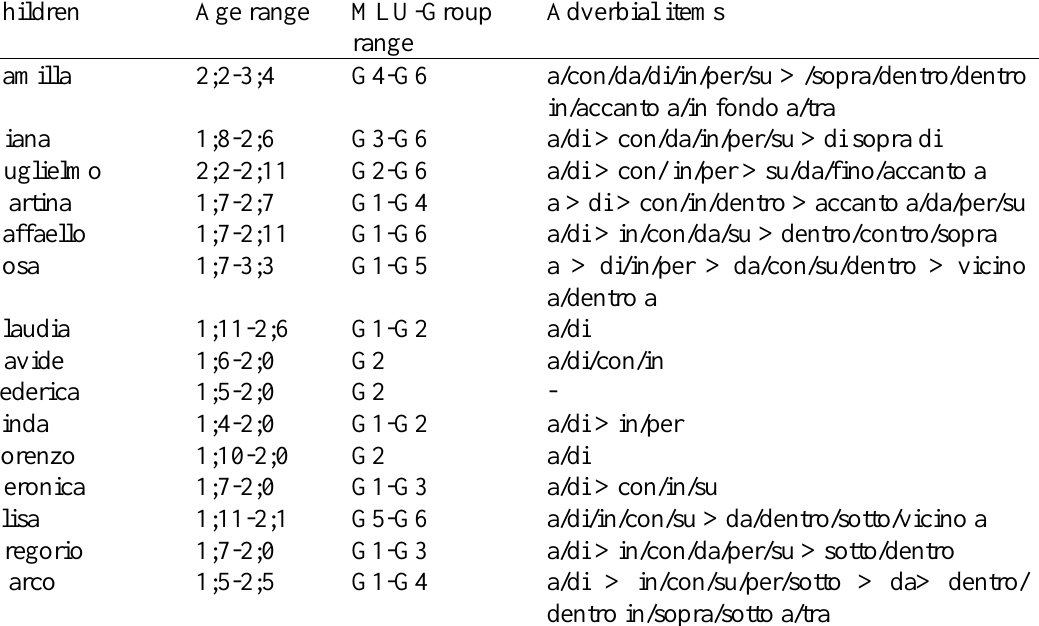
Table 8 . Order of production of the prepositional items across children (P+XP